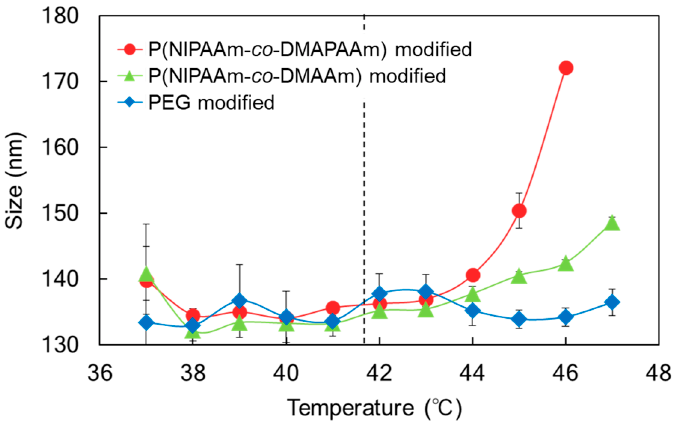
Figure 4. Temperature dependent size change of liposomes in PBS. The dashed line indicates the LCST of the thermoresponsive polymers.